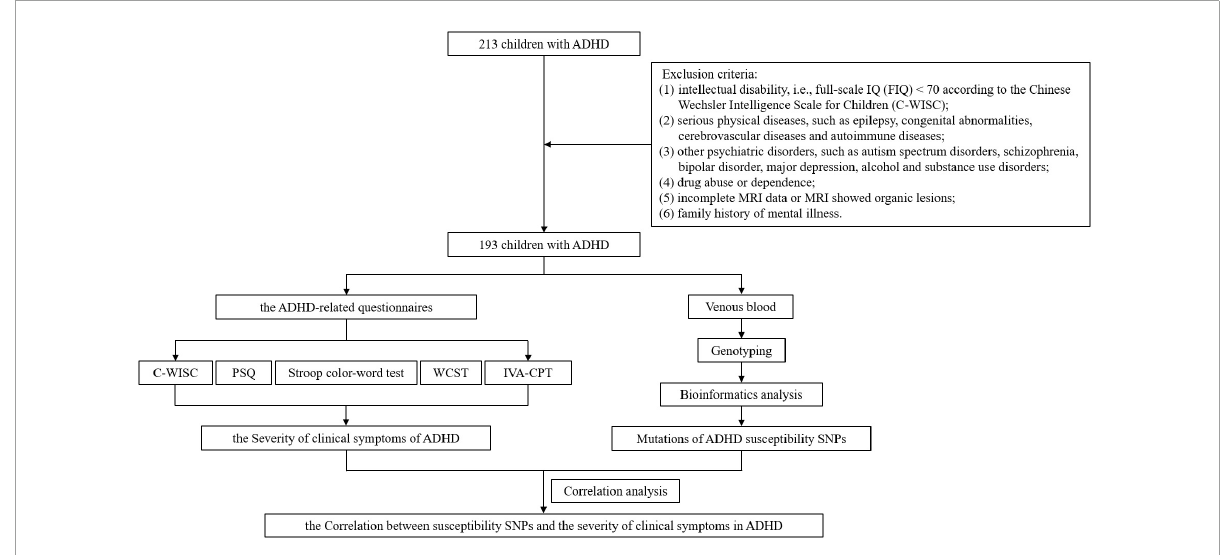
FIGURE1 The workflow of the